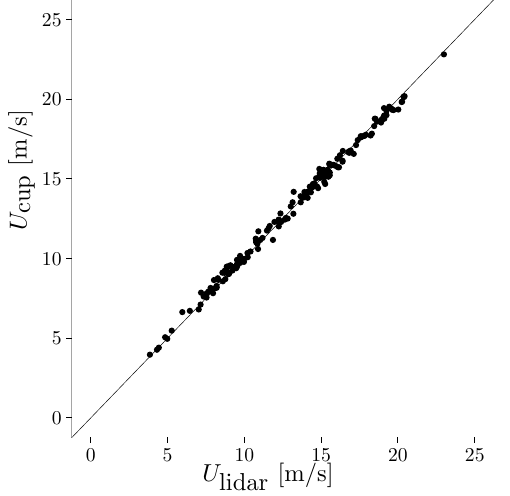
Figure 1. Comparison of wind speed measurements from the wind lidar and cup anemometer at 100m height for 10min